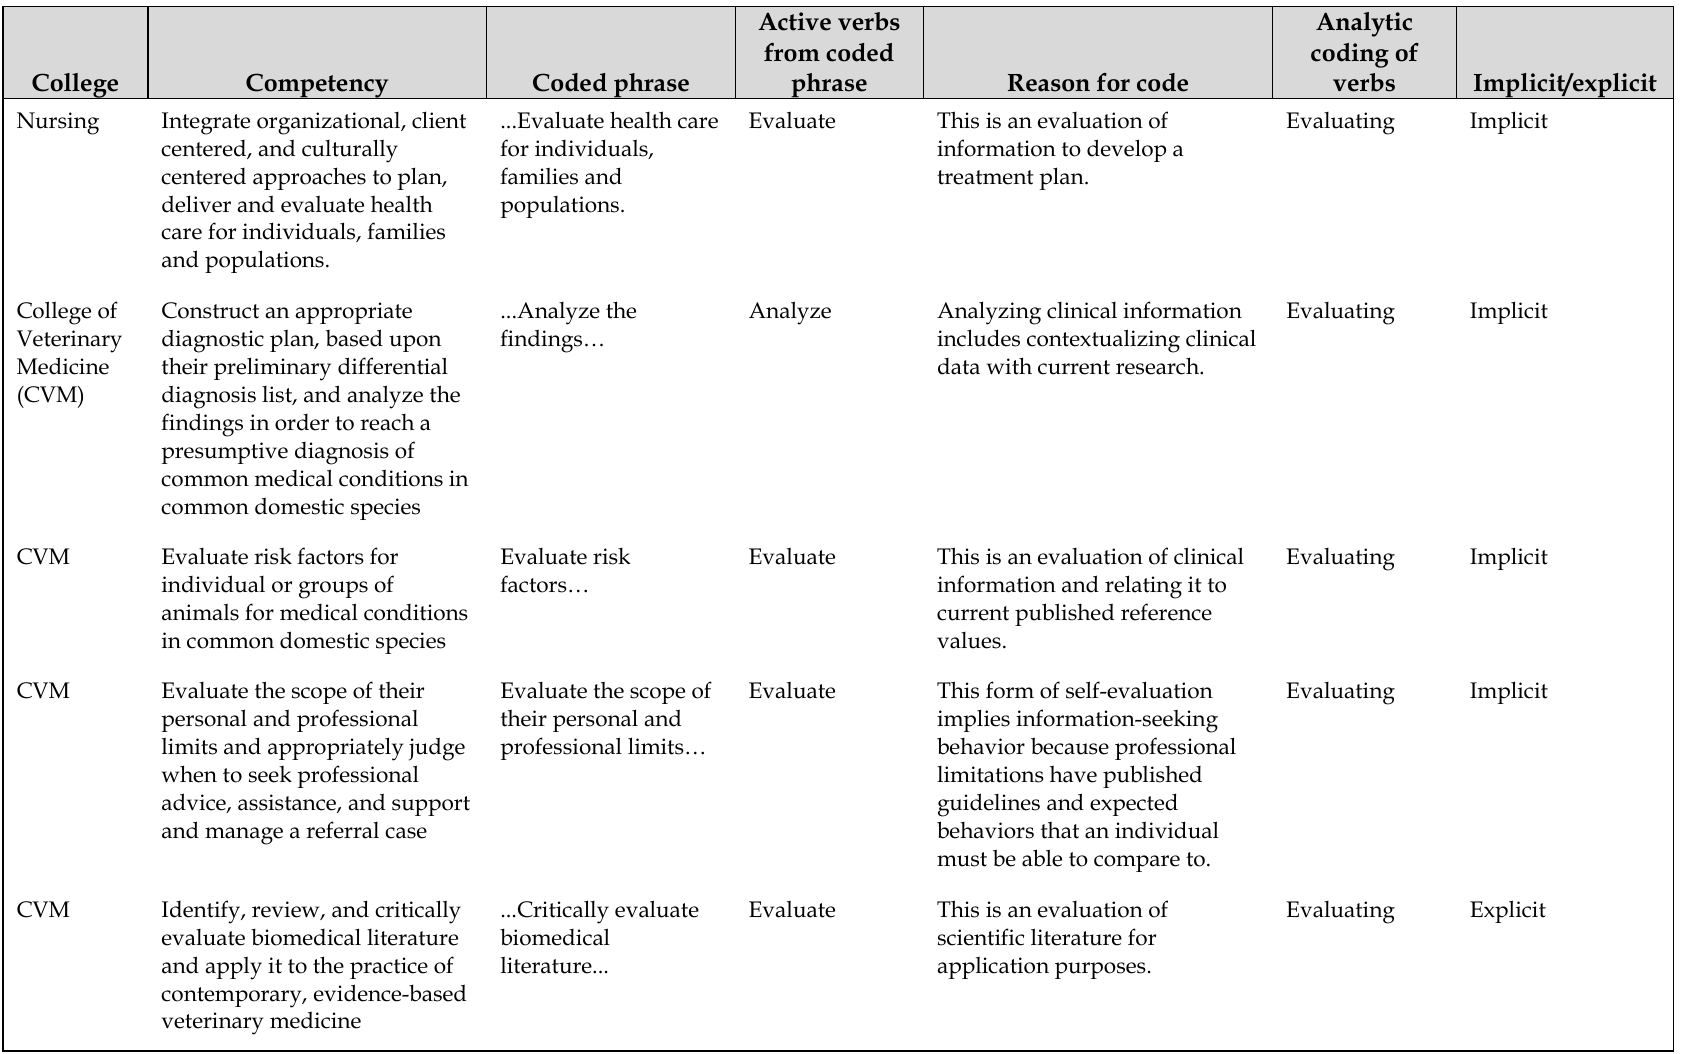
Table 2 Competencies with implicit or explicit information skills and behaviors